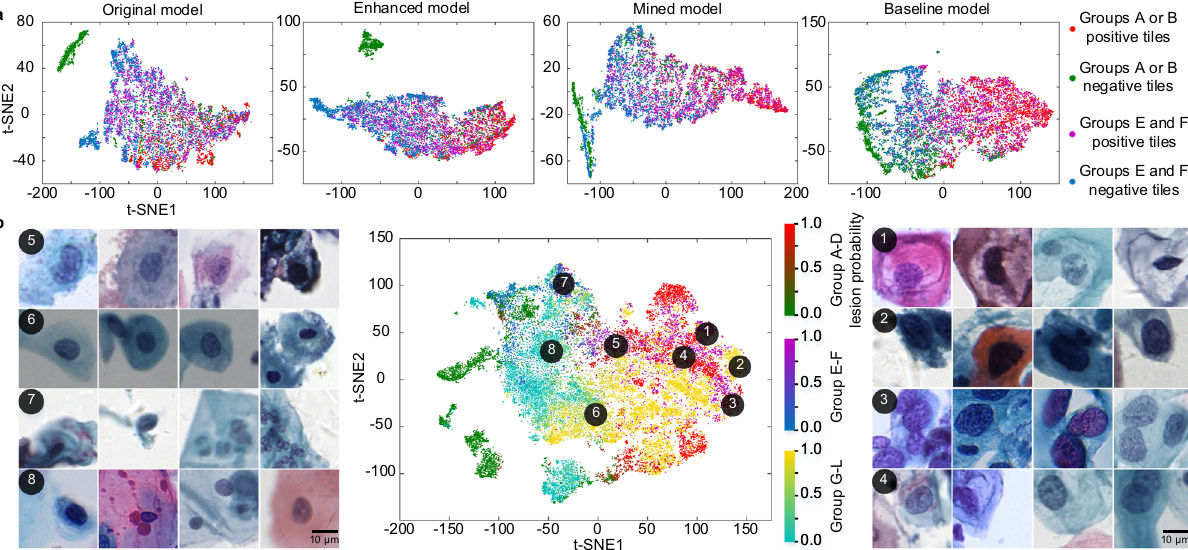
Fig. 7 Generalized and rich feature representations of our models. a Gradually aligned features between different groups of datasets. The last 2,048- dimensional features of the original, enhanced, and mined models were reduced to two dimensions using t-SNE on the test sets of groups A, E, and F and were plotted in the fi rst three subgraphs respectively. The dimension-reduced features of the baseline model on the test sets of groups A, B, E, and F were plotted in the fourth subgraphs. In all, 1,000 positive test tiles and 1,000 negative test tiles in each group were randomly selected for the visualization. b The distribution of dimension-reduced features of the HR model on the 12 groups test sets and the interpretation of the feature representations by examining the corresponding cervical image tiles. In all, 2,000 test tiles in each group were randomly selected for the feature visualization. The different color bars refer to different groups and the gradient colors within a single color bar refer to the lesion probabilities of